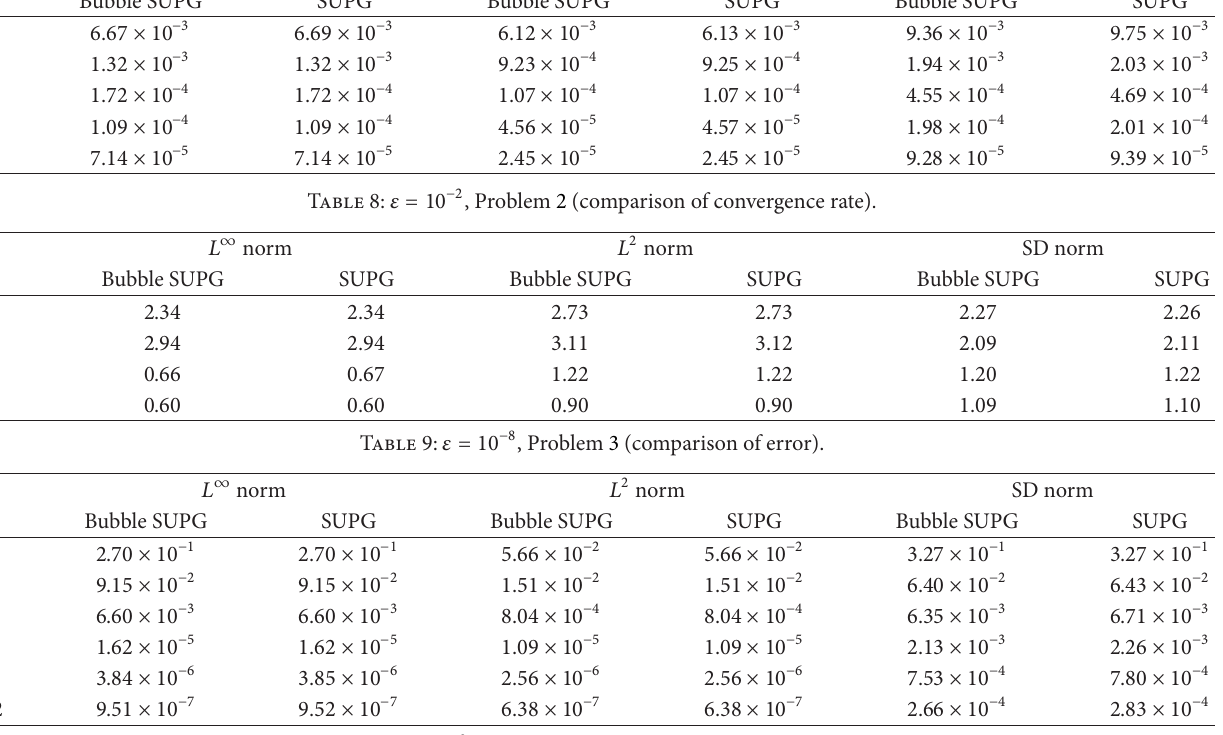
Table 10: 𝜀 = 10 −8 , Problem 3 (comparison of convergence rate).